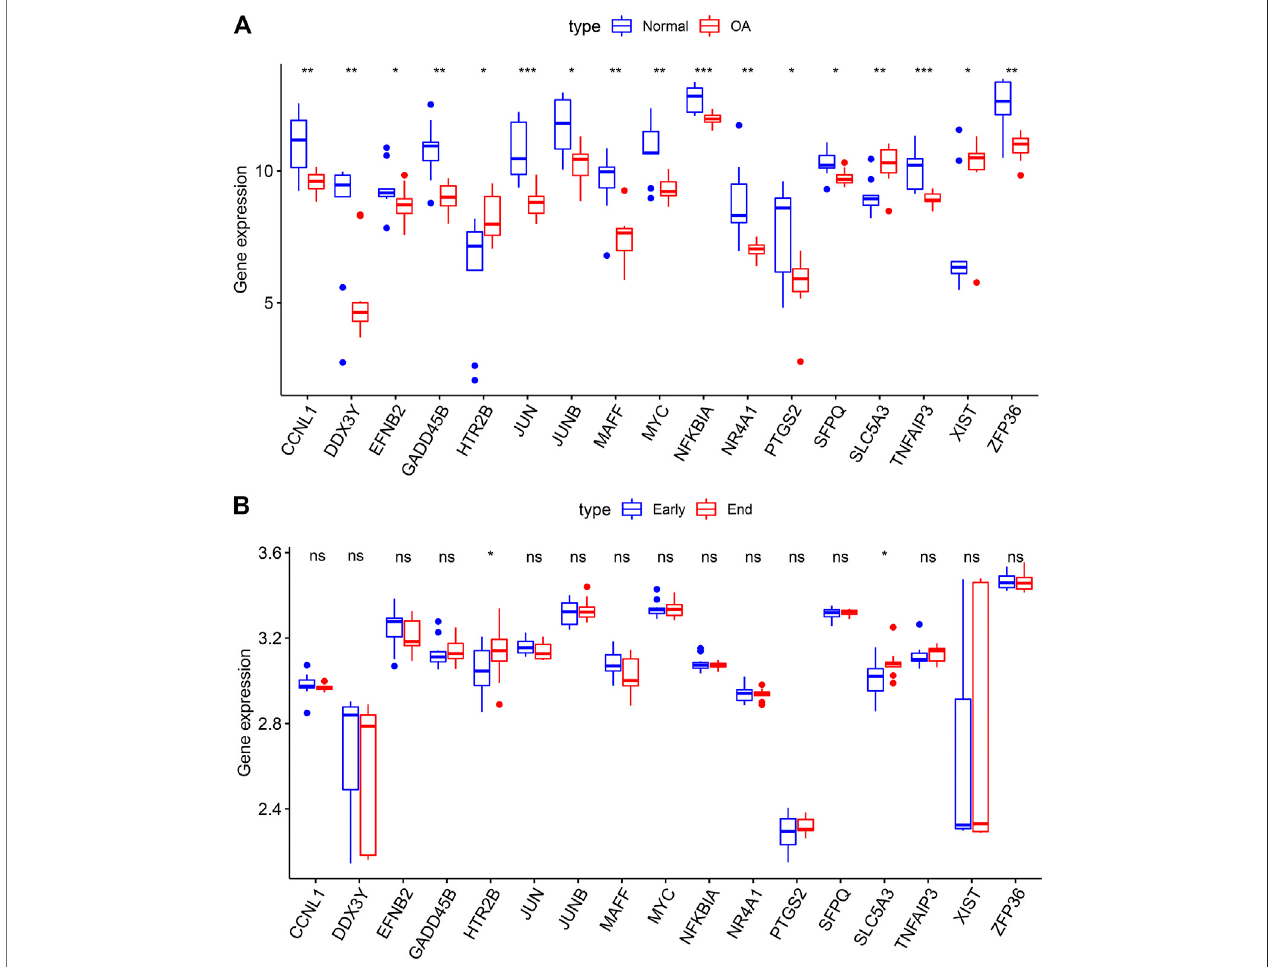
FIGURE 5 | Validation of OA-speci fi c DEGs in the GSE12021 and GSE32317 datasets. (A) Box plots for the expression patterns of these 17 OA-speci fi c DEGs in normal and OA synovial tissues in the GSE12021 dataset. (B) Box plots for validation of the expression of the OA-speci fi c DEGs in early- and end-stage OA synovial membrane samples in the GSE32317 dataset. Ns: not signi fi cant; * p < 0.05; ** p < 0.01; *** p < 0.001.